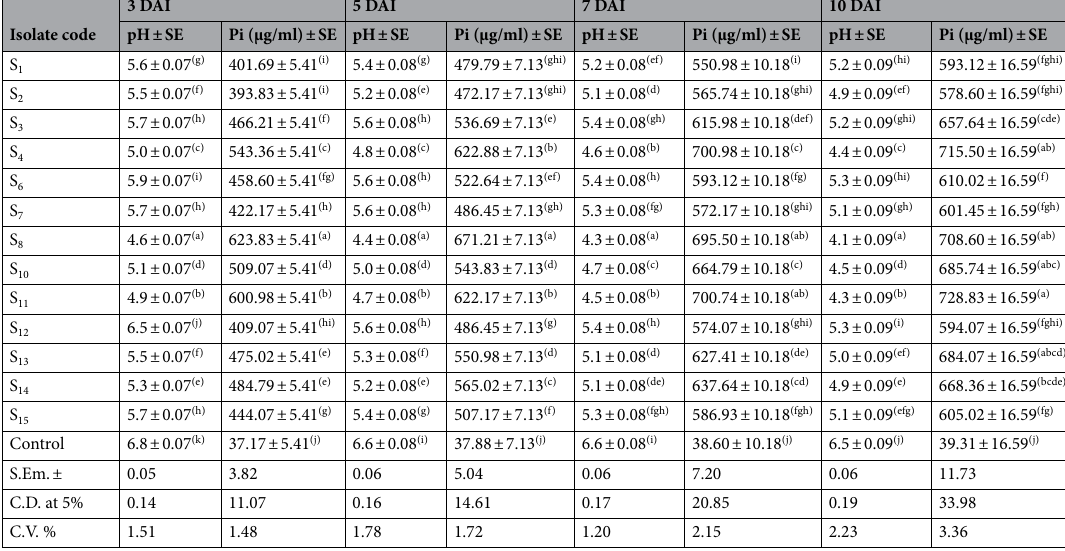
Table 7. pH drop and Pi released from TCP broth by isolates on 3, 5, 7 and 10 DAI. Pi inorganic phosphorous. Values of pH and Pi released (μg ml −1 ) are mean ± standard error of 3 replicates. Different letters at various points indicate significant difference between treatments using Duncan’s multiple range test (P ≤ 0.01).